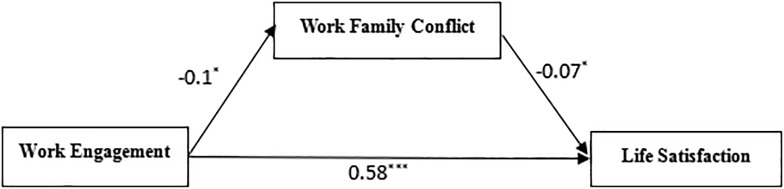
Path coefficients of work engagement, work-family conflict and life satisfaction. ∗P 0.05, ∗∗∗P 0.001.